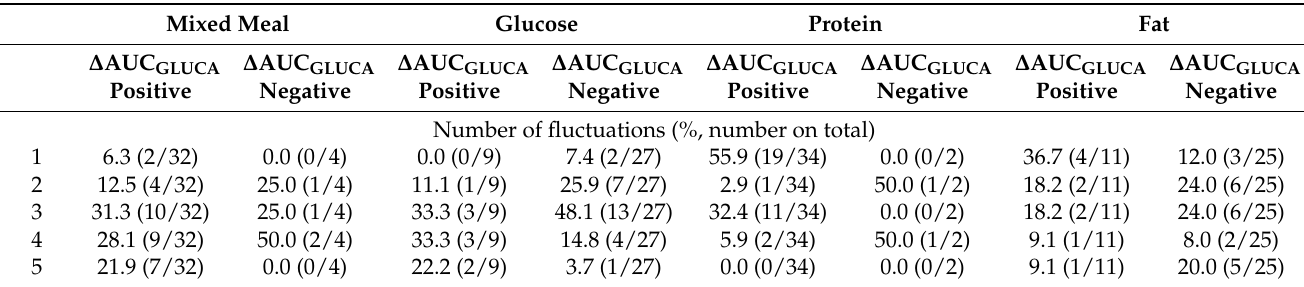
Table 5. Number of fluctuations of glucagon curves in different metabolic